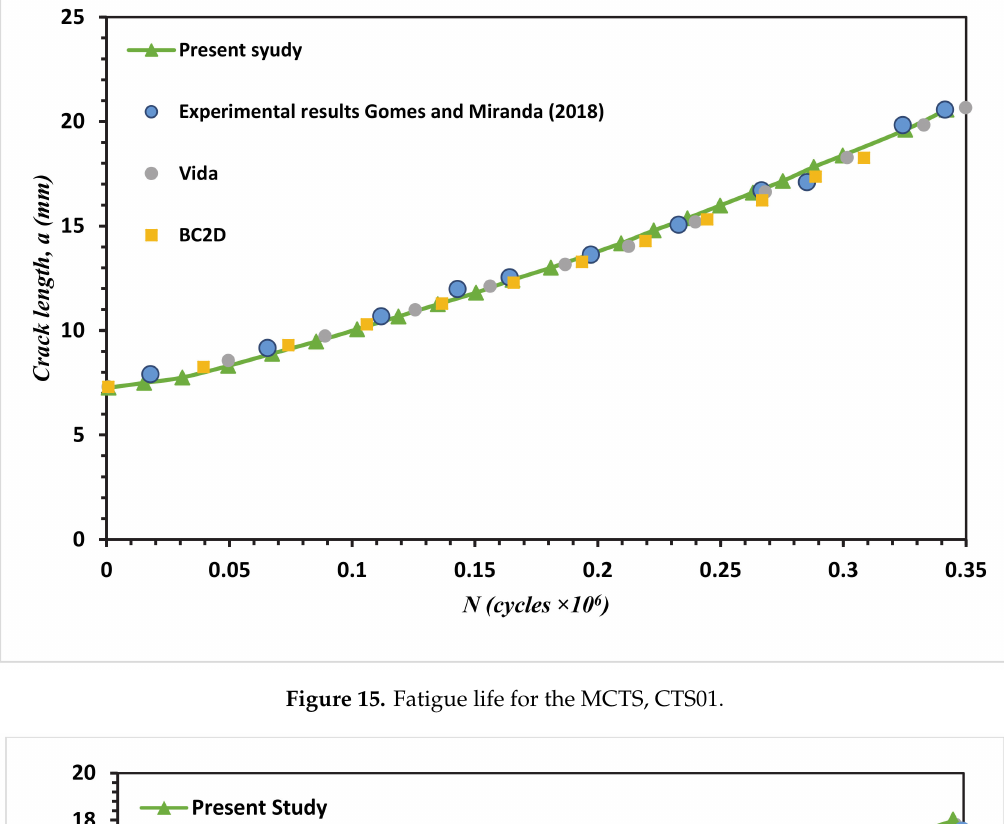
Figure 15. Fatigue life for the MCTS, CTS01.